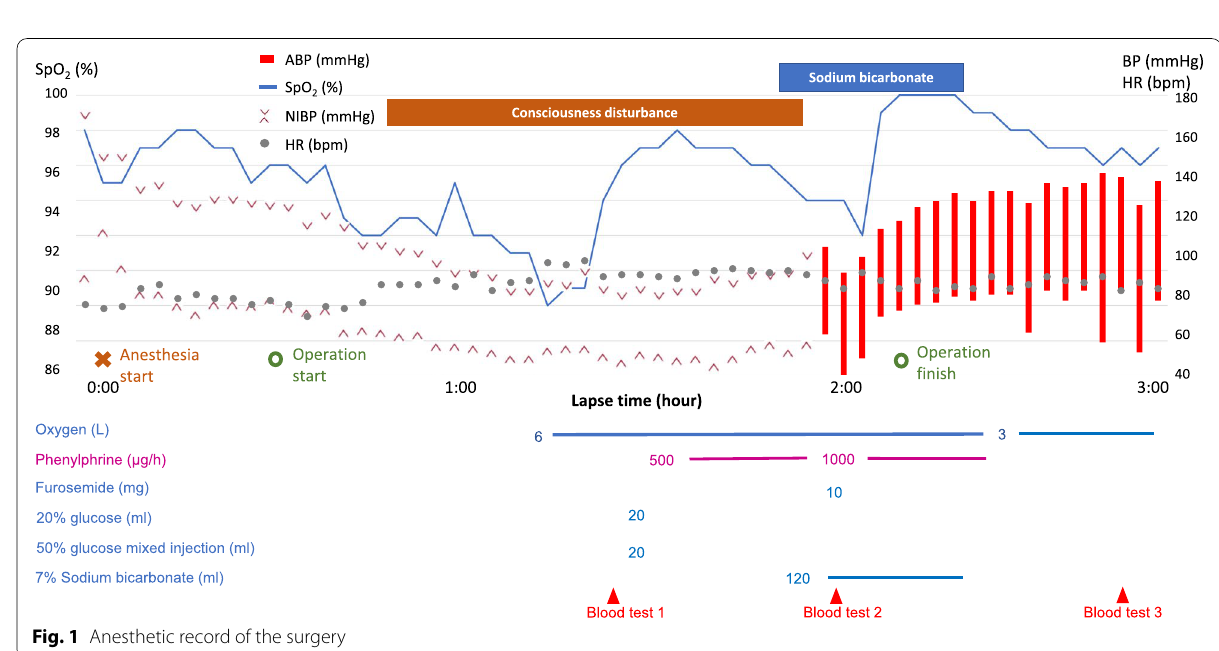
Fig. 1 Anesthetic record of the